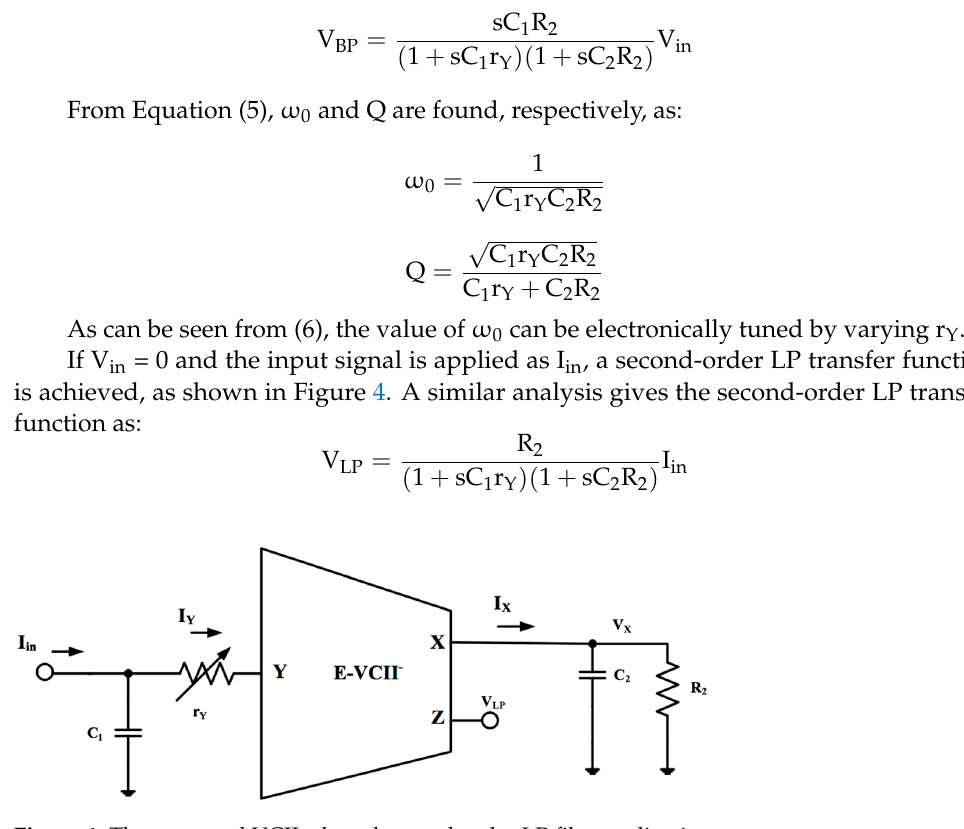
Figure 4. The proposed VCII - -based second-order LP filter realization.